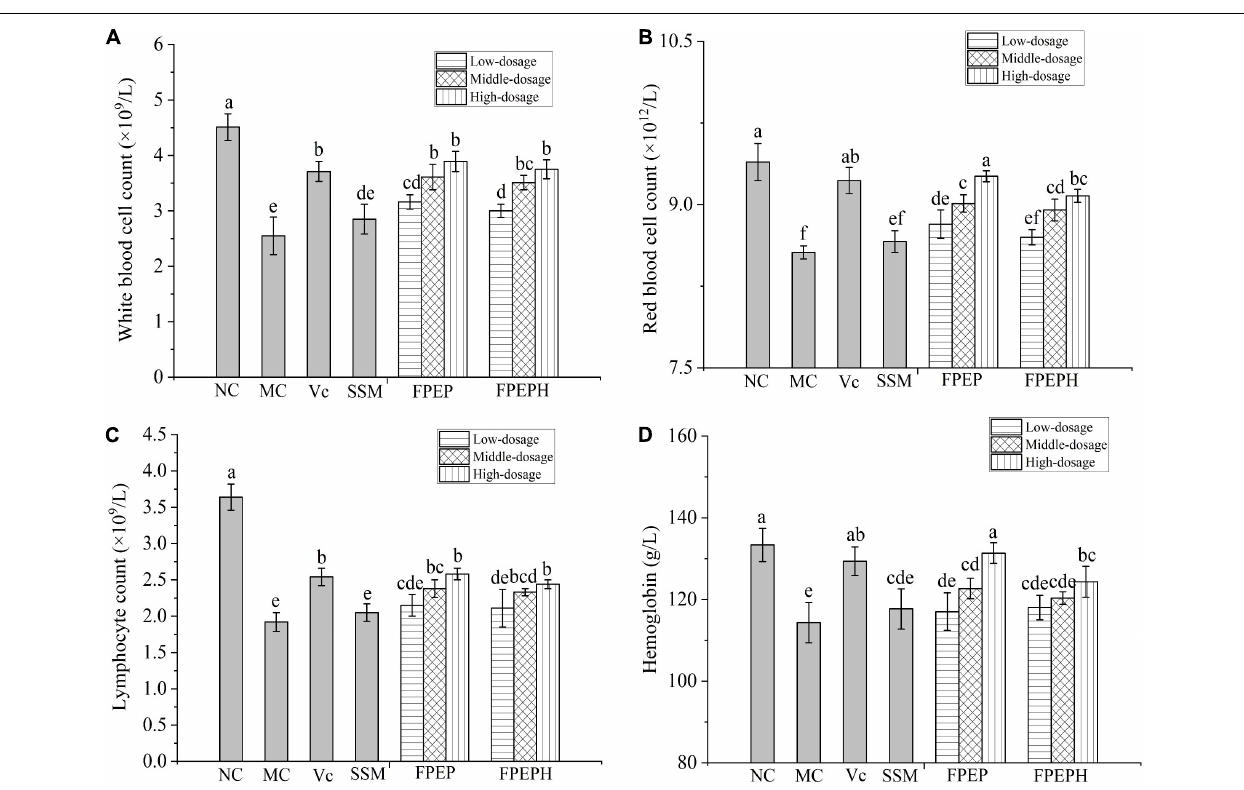
FIGURE 3 | Effects of sour soybean milk on improving blood cells level in mice. (A) White blood cell count, (B) red blood cell count, (C) lymphocyte count, and (D) hemoglobin. Data were presented as the Mean ± S.D. The same letters indicated no significant differences and different letters indicated significant differences at P < 0.05. NC: control group; MC: model group; Vc: vitamin C-ascorbic acid; SSM: sour soybean milk; FPEP: fermented with P. eryngii polypeptides with a molecular weight of < 3 kDa; FPEPH: fermented with P. eryngii protein